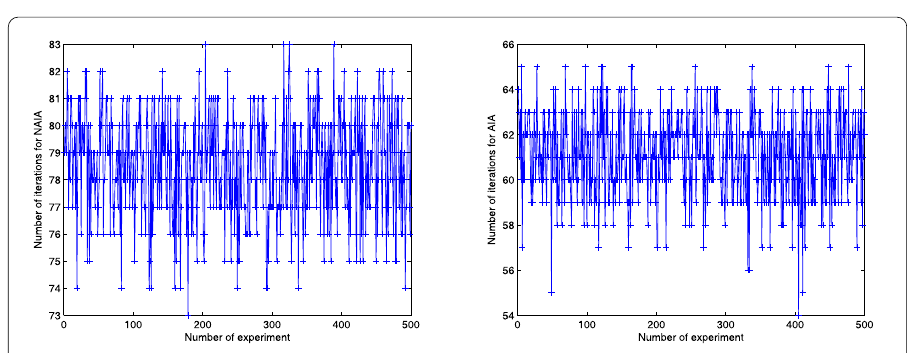
Figure 2 The iterative number of NAIA and AIA for the initial point of Case 2